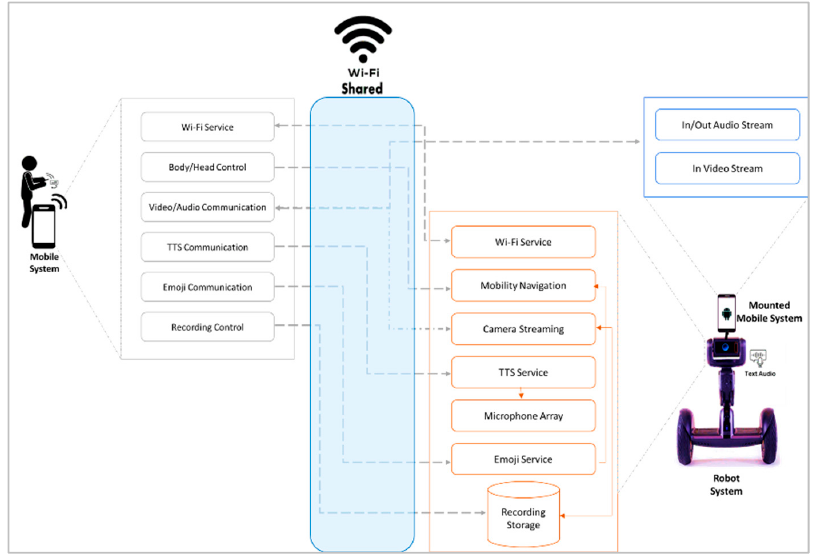
Figure 2. Framework of the proposed MRP system.